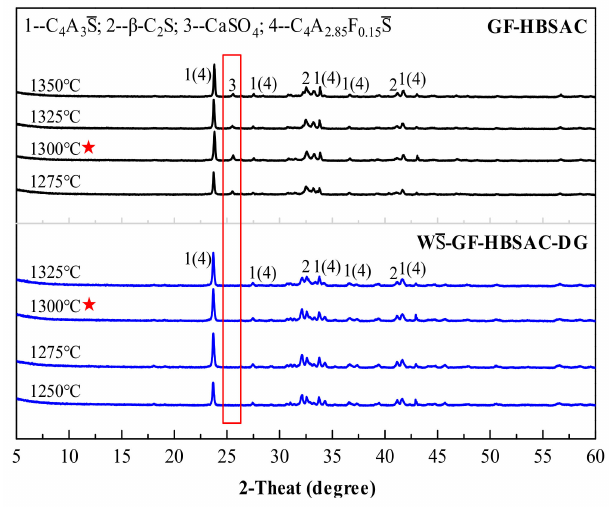
Figure 4. X-ray di ff raction (XRD) patterns of the Series GF-HBSAC-X cement clinkers at di ff erent temperatures. Table 3. Chemical composition and the three moduli of the Series GF-HBSAC-X cement clinkers.